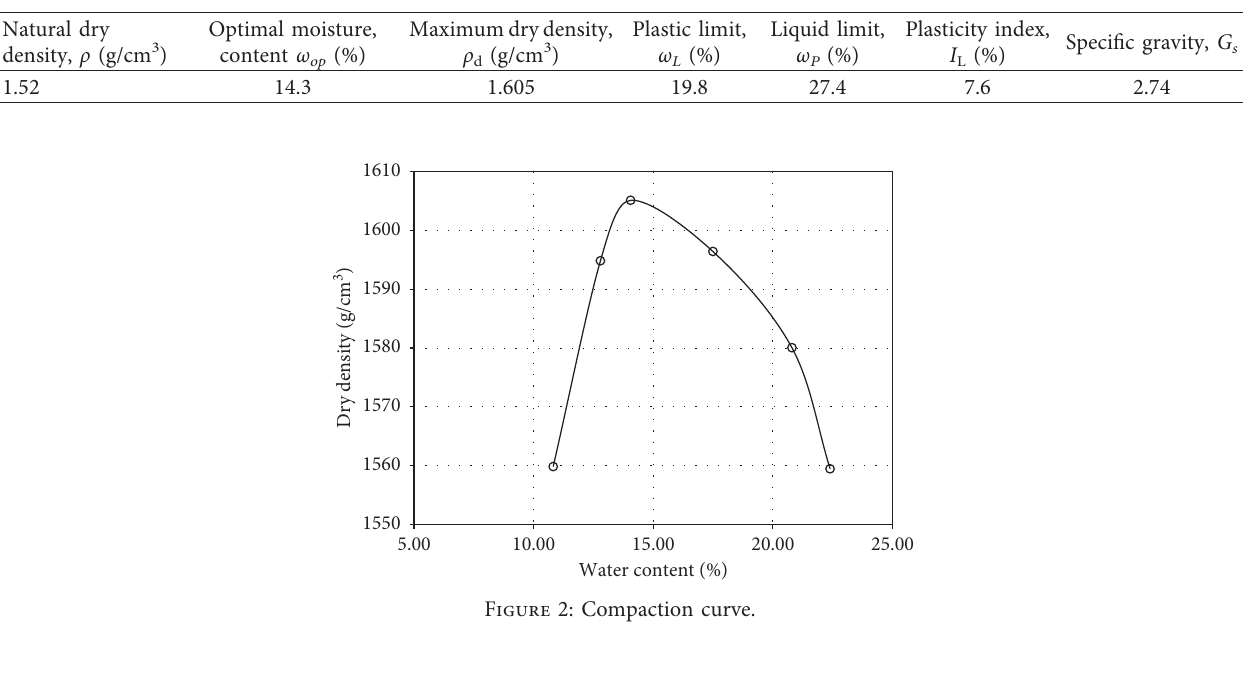
Figure 1: The sampled Table 1: Basic properties of clay.